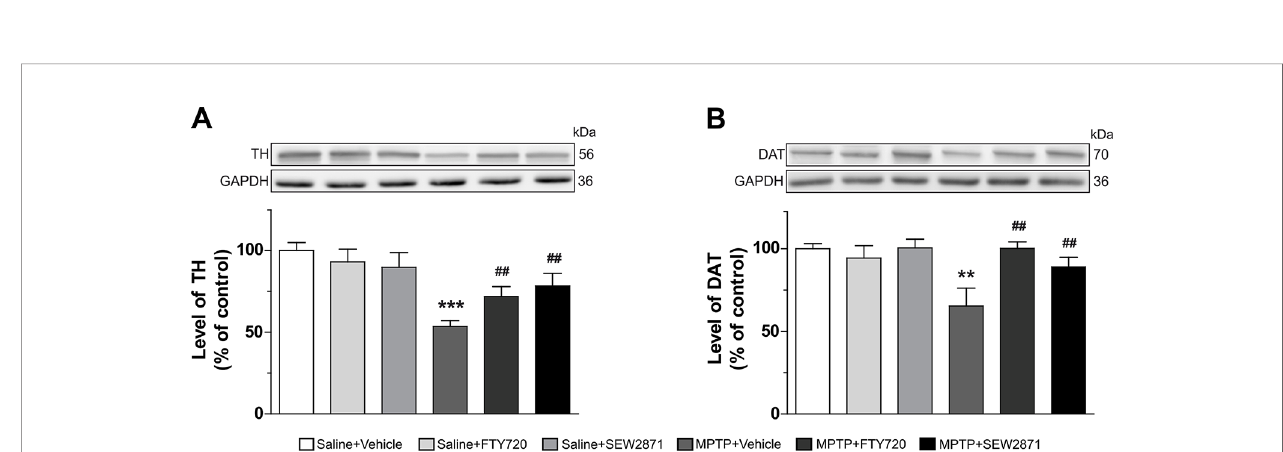
FIGURE 5 | S1PR modulators protect against 1-methyl-4-phenyl-1,2,3,6-tetrahydropyridine (MPTP)-induced subtantia nigra pars compacta (SNc) cellular loss. Representative examples of tyrosine hydroxylase (TH)-immunostaining (green) using the 40X objective of the epi fl uorescence microscope in coronal sections ( − 3.16 mm from the Bregma) of mouse subtantia nigra pars reticulate (SNr). Bar equals 50 µm (A) . Stereological counts of TH- and neuronal nuclear antigen (NeuN)-positive neurons in the SNc (B, D) and ventral tegmental area (VTA) (C, E) . The data represent the mean of TH- and NeuN-positive cell numbers/mm 3 (expressed as a percentage of control values) ± S.E.M., n = 3-5 mice/group. * p < 0.05, ** p < 0.01 vs . vehicle + saline; # p < 0.05, ## p < 0.01 vs . vehicle + MPTP.